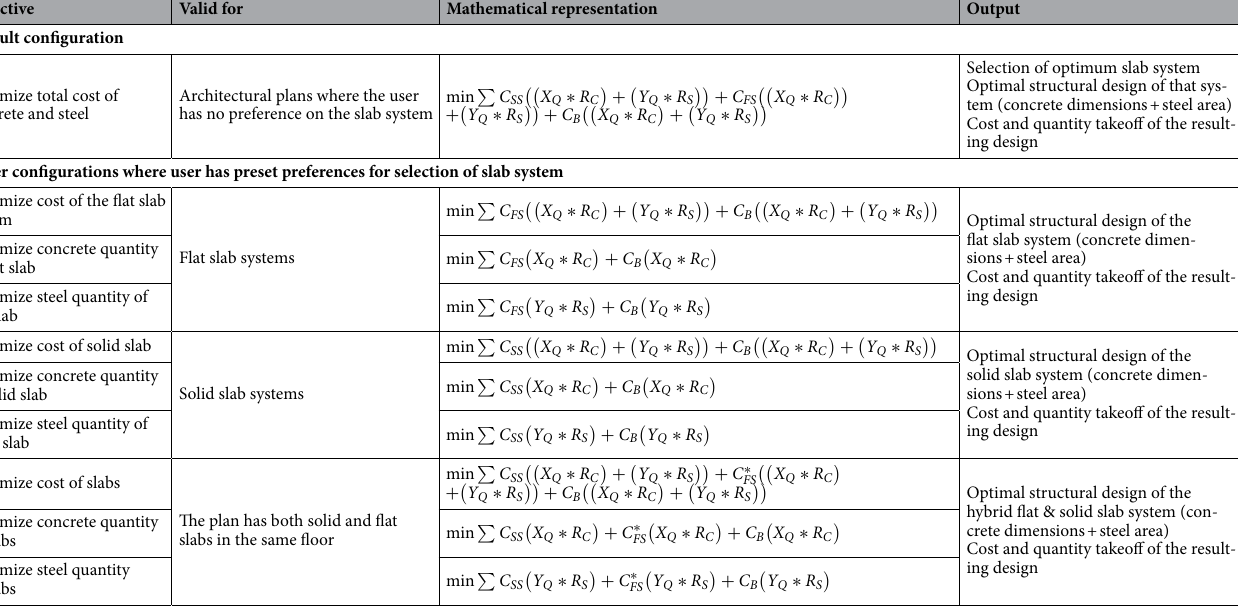
Table 1. Objective functions by the developed model. where C SS Cost of solid slabs which is a function of quantity and unit rate; C FS Cost of Flat slabs which is a function of quantity and unit rate; C B Cost of Beams which is a function of quantity and unit rate; X Q Total quantity of reinforcement concrete material; R C